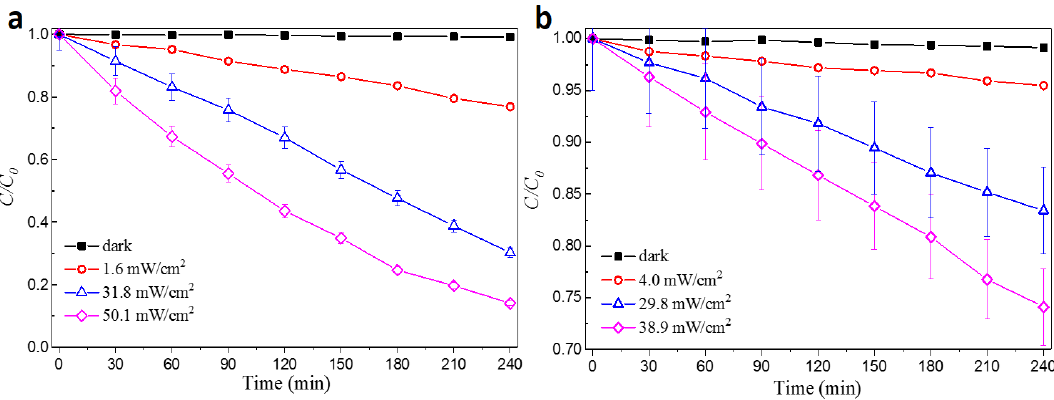
Figure 8. E ff ect of light intensity on the SMT degradation kinetics by ZnO / Cu x = 1.25 O under ( a ) simulated Figure 8. Effect of light intensity on the SMT degradation kinetics by ZnO/Cu x = 1.25 O under ( a ) solar light and ( b ) visible light. Solution parameters: [catalyst] = 500 mg / L, [SMT] = 2.5 mg / L and simulated solar light and ( b ) visible light. Solution parameters: [catalyst] = 500 mg/L, [SMT] = 2.5 mg/L initial pH and initial pH 7.0.